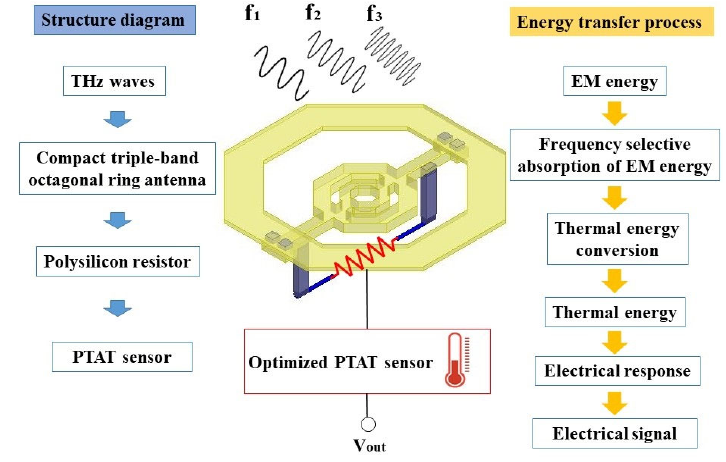
Figure 1. Schematic diagram of the proposed triple ‐ band detector.